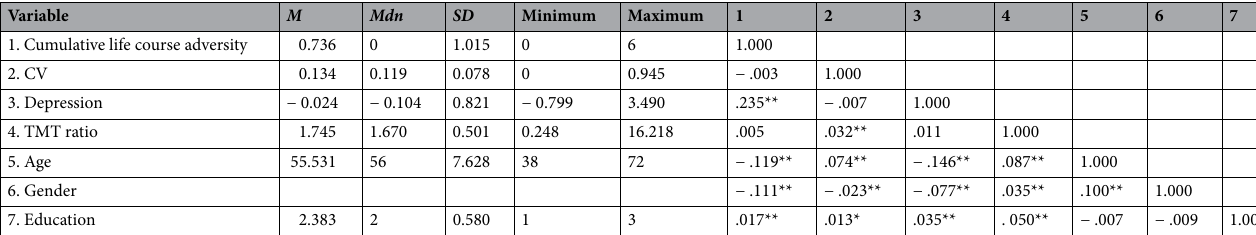
Table 3. Descriptive statistics and Spearman correlations with a Bonferroni correction for all the variables of the model. * p ≤ .01. ** p ≤ .001. CV Coefficient of variation, TMT The Trail Making Test.